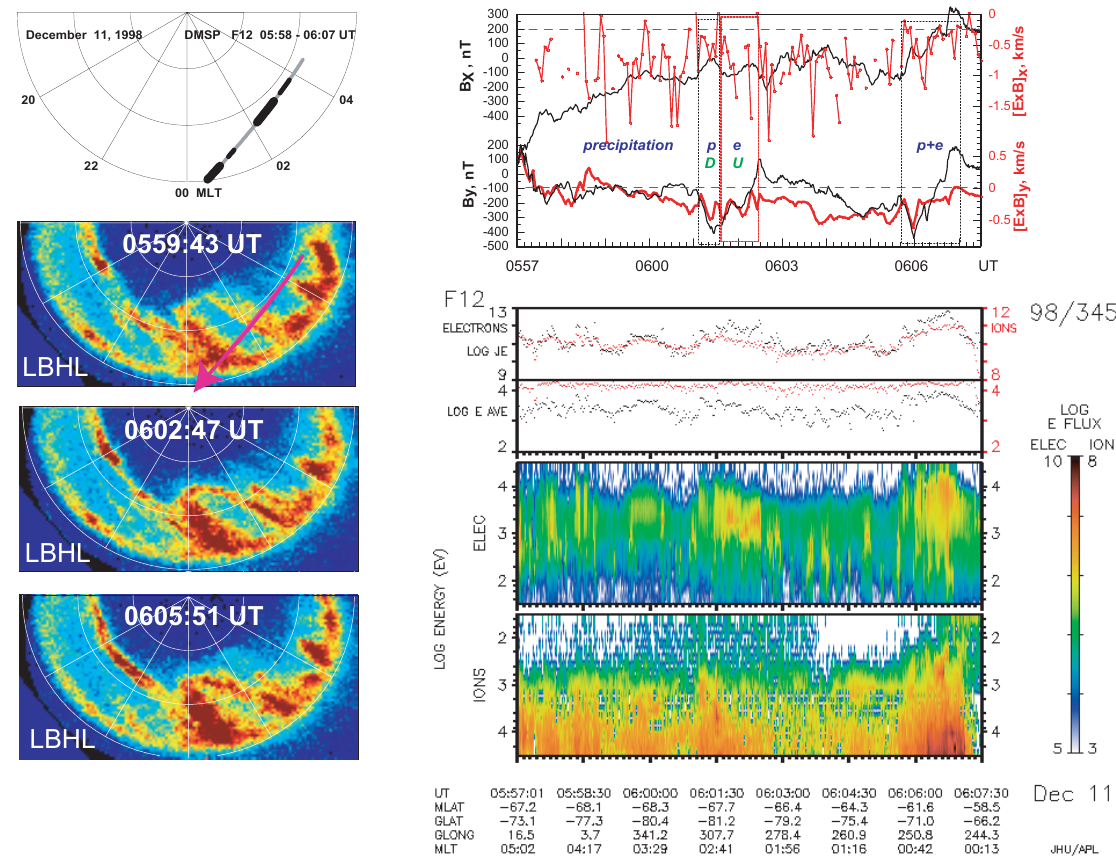
Fig. 4. Summary of DMSP F12 observations during the streamer crossings at 06:01 UT and 06:05 UT.